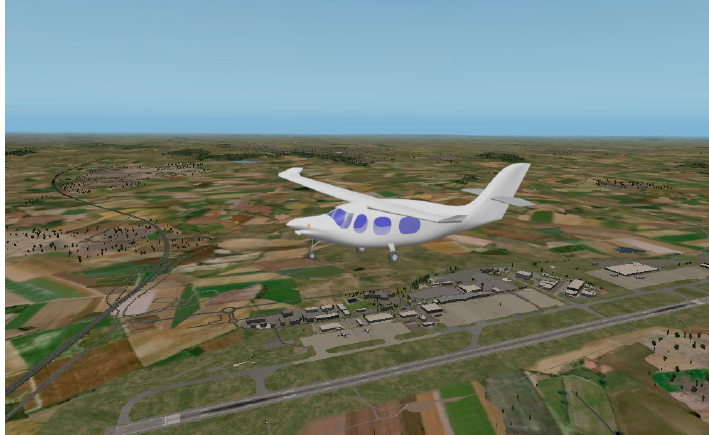
Figure 17. AUXX conventional rendered model for X-Plane simulation.